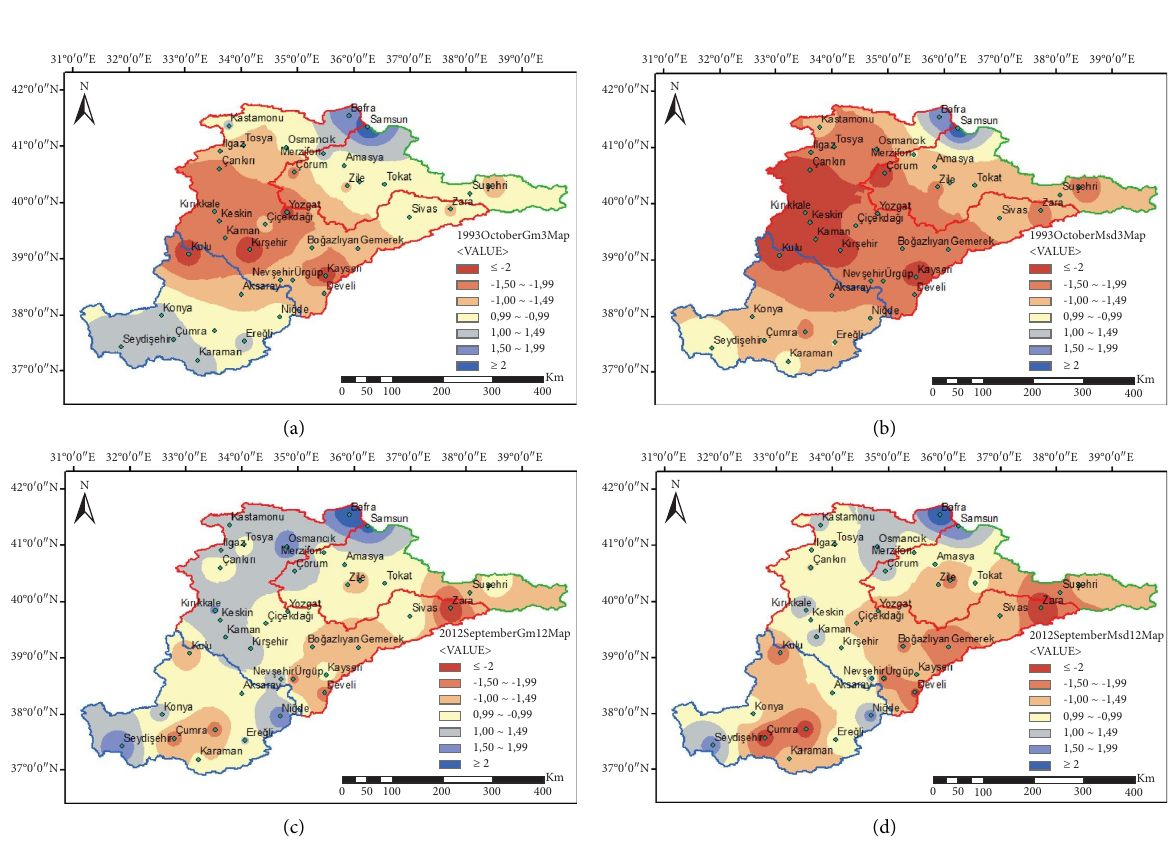
Figure 4: Comparison of spatial distributions of SPI3 and SPI12 drought calculations according to Gamma distribution and most suitable distributions (MSD) for selected months: (a) SPI3 with Gamma for October 1993, (b) SPI 3 with MSD for October 1993, (c) SPI 12 with Gamma for September 2012, and (d) SPI12 with MSD for September